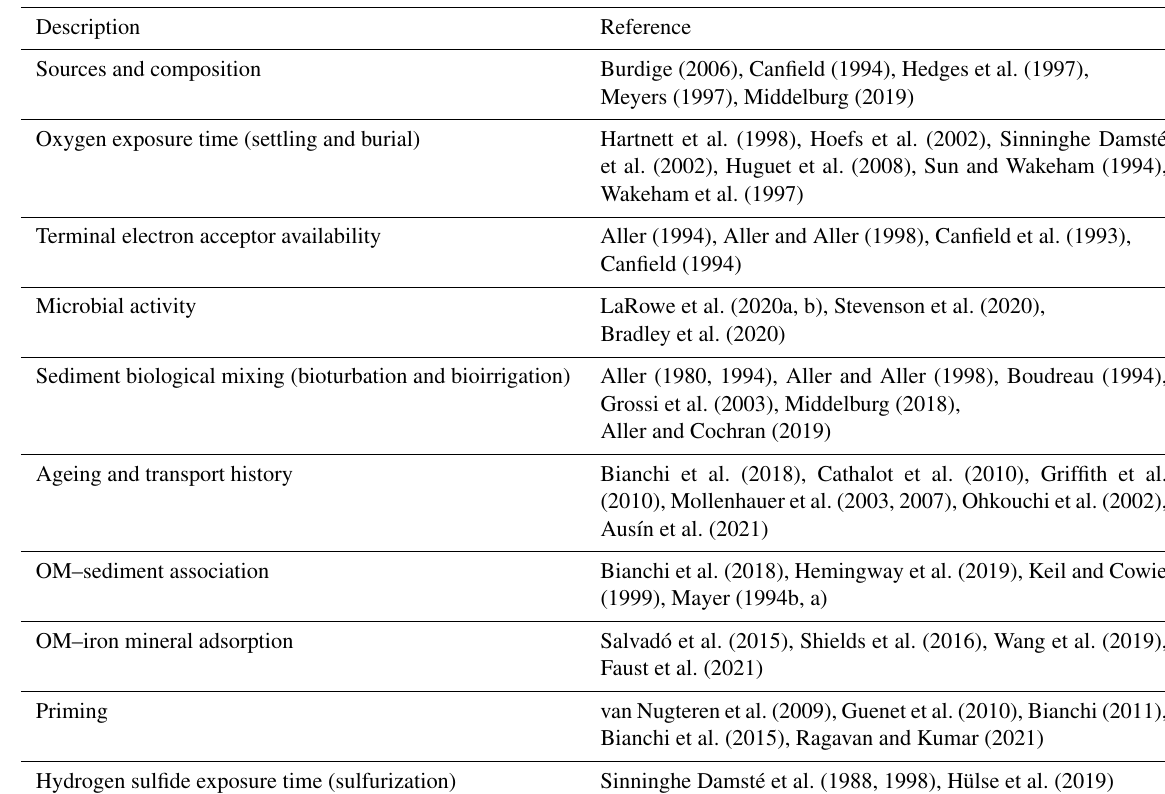
Table 1. Environmental factors influencing organic matter reactivity in marine